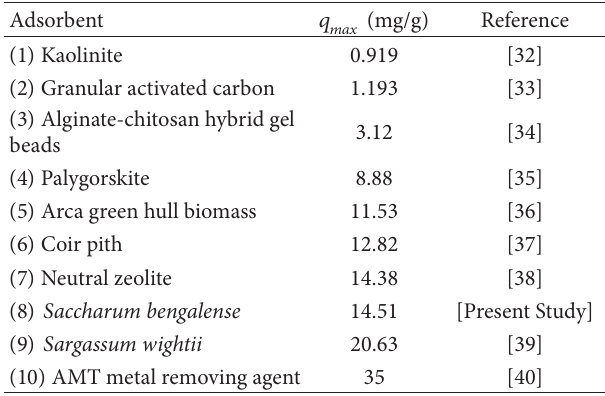
T 5: Comparison of adsorption potential of various adsorbents for cobalt removal from aqueous